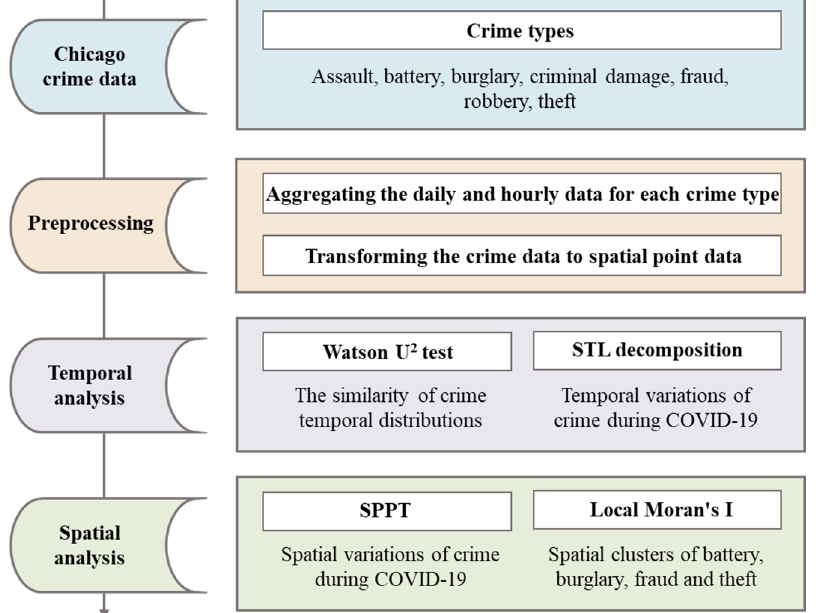
Figure 1. Workflow of the analytical process.